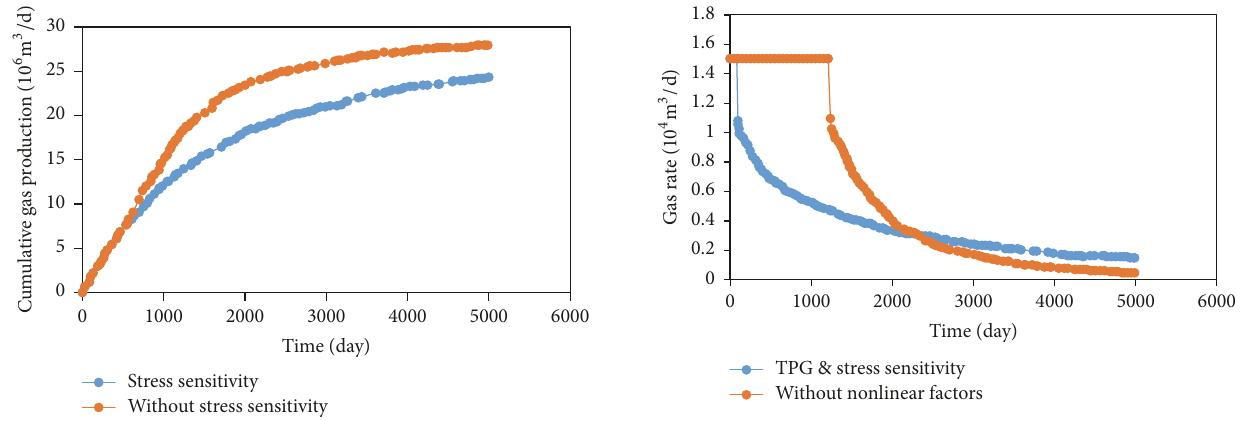
Figure 11: Effect of stress sensitivity on cumulative gas production.